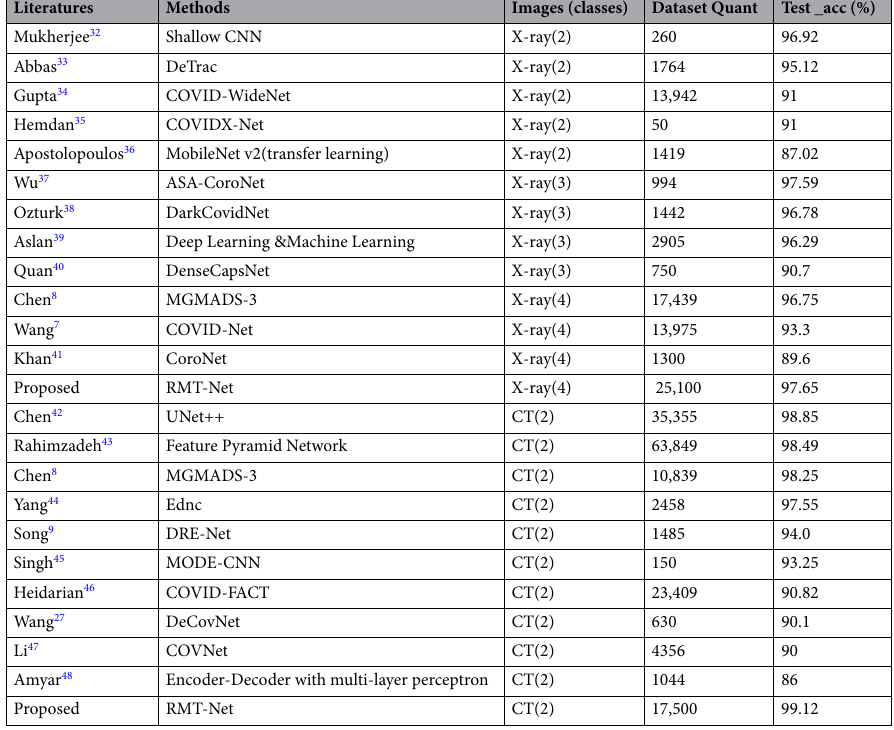
Table 4. Comparisons with related